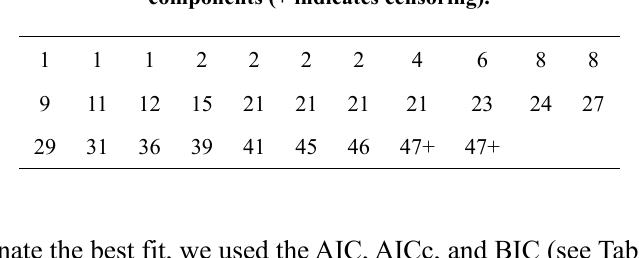
Dataset related to the agricultural machines with failure in electrical components (+ indicates censoring).